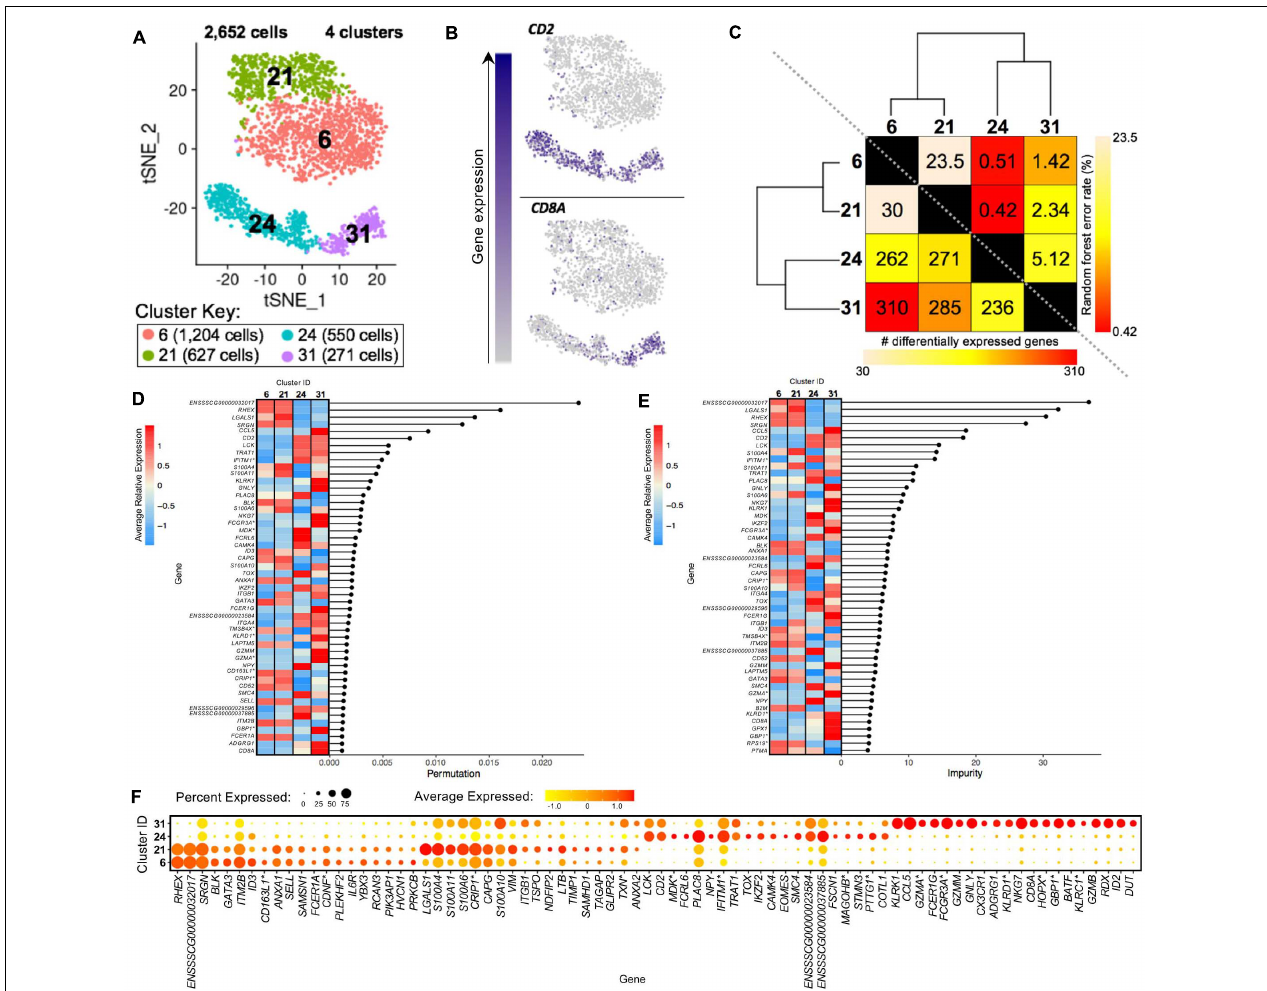
FIGURE 8 | Transcriptional heterogeneity of porcine γδ T-cells at single-cell resolution. (A) Two-dimensional t-SNE plot of 2,652 cells belonging to clusters designated as CD2 − γδ T-cells (clusters 6, 21) or CD2 + γδ T-cells (clusters 24, 31) in Figure 4D . Each point represents a single cell. Color of the cell corresponds to transcriptional cluster a cell belongs to. Cells more transcriptionally similar to each other belong to the same cluster. (B) Visualization of selected gene expression overlaid onto t-SNE coordinates of single γδ T-cells. Each point represents a single cell. Color of the point corresponds to relative expression of a specified gene (top left of each t-SNE plot) within a cell. Gray corresponds to little/no gene expression, while navy corresponds to increased gene expression. (C) Transcriptomic relationship amongst γδ T-cell clusters as calculated by three methods: hierarchical clustering (as seen by hierarchical trees on both axes), pairwise random forest analyses (as seen on top right diagonal); and pairwise DGE analyses (as seen on bottom left diagonal). Longer branches on the hierarchical tree corresponds to greater hierarchical distance. Lower numbers of DEGs by DGE analysis and higher out-of-bag (OOB) error rates from random forest analyses indicate greater pairwise transcriptional similarity. (D,E) Genes with the largest effects in discriminating γδ T-cells by cluster identities were determined, as indicated by high permutation (D) and/or impurity scores (E) calculated from a trained random forest model. Average relative expression for each of these genes within clusters is also depicted by a heatmap. (F) Dot plot of up to the top 20 DEGs having logFC > 0 from overall DGE analysis of only γδ T-cell clusters. Clusters are listed on the y -axis, while selected DEGs are listed on the x -axis. The size of a dot corresponds to the percent of cells in a cluster that expressed the gene. The color of a dot corresponds to the average relative expression level for the gene in the cells expressing the gene within a cluster. *Refer to ‘Gene name replacement’